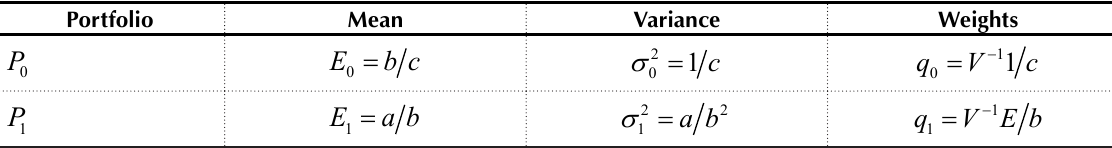
Table 1. Properties of portfolios 0 and 1 in terms of , a b and c Portfolio